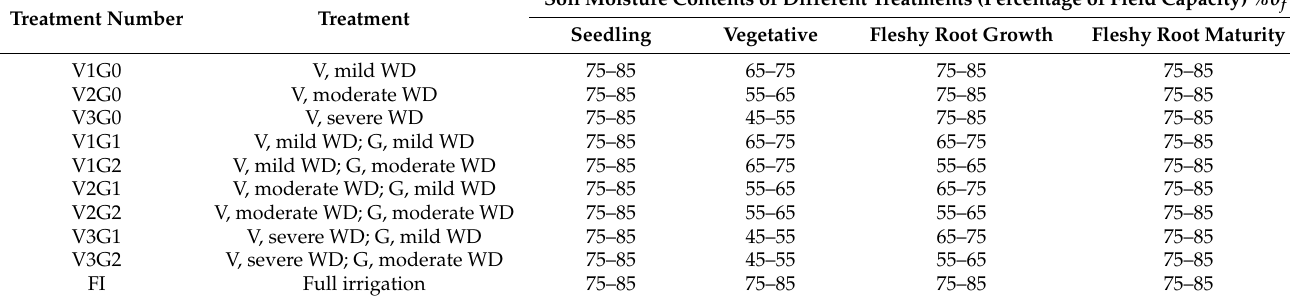
Table 1. The WDI